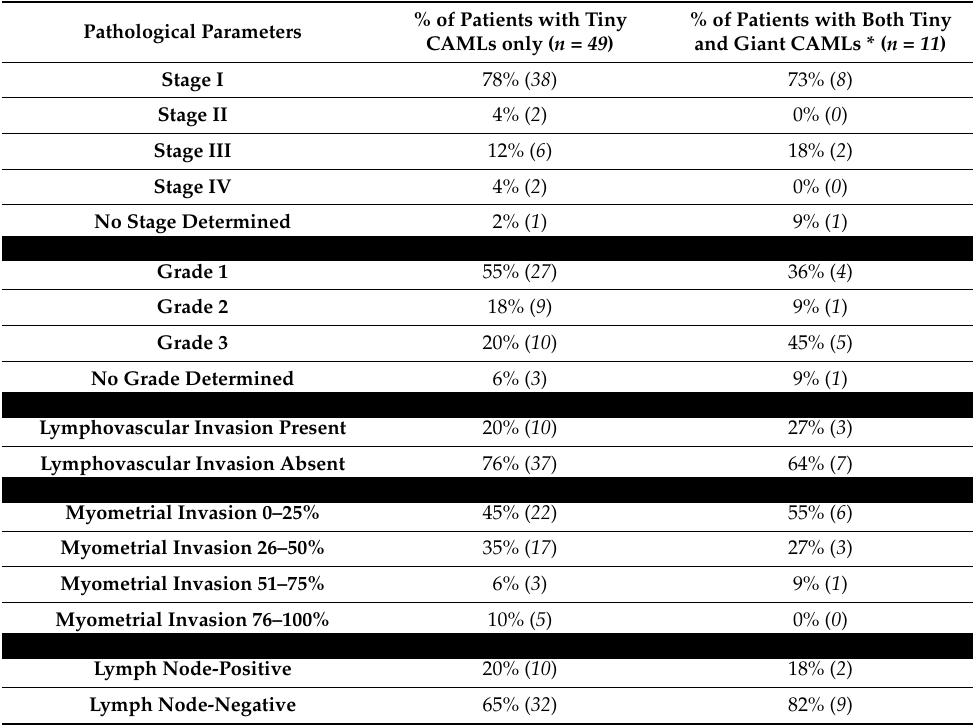
Table 3. Pathological parameters of 63 patients with endometrial cancers bearing different sizes of CAMLs (tiny/giant).